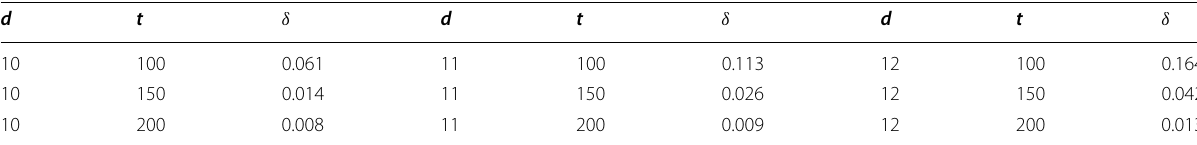
Table 5 Avalanche test of the pre-randomiser